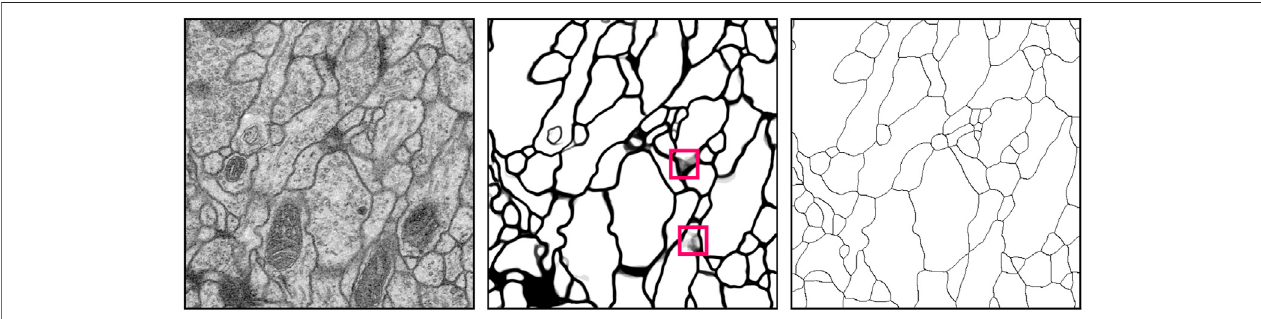
FIGURE 7 | Example results of cellular membrane segmentation on test data from the ISBI 2012 EM segmentation challenge (slice 22/30) illustrating an input EM image (left) , the probability prediction from FusionNetW 2 64 (middle) , and the thinned probability prediction after applying LMC (Beier et al., 2017) post-processing (right) . Pink boxes highlight uncertain regions that are ambiguous because of membrane smearing, likely due to anisotropy in the data.